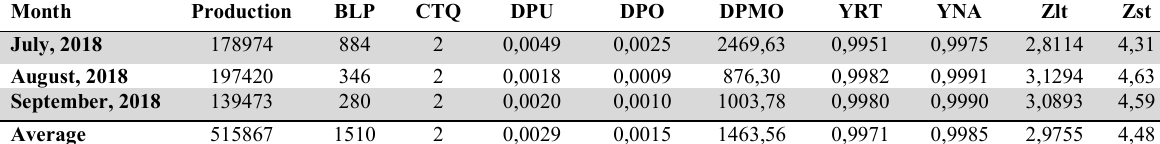
Table 1 indicates that sigma level (Zst) month of July ~ September 2018 is 4.48 sigma. Further mapping